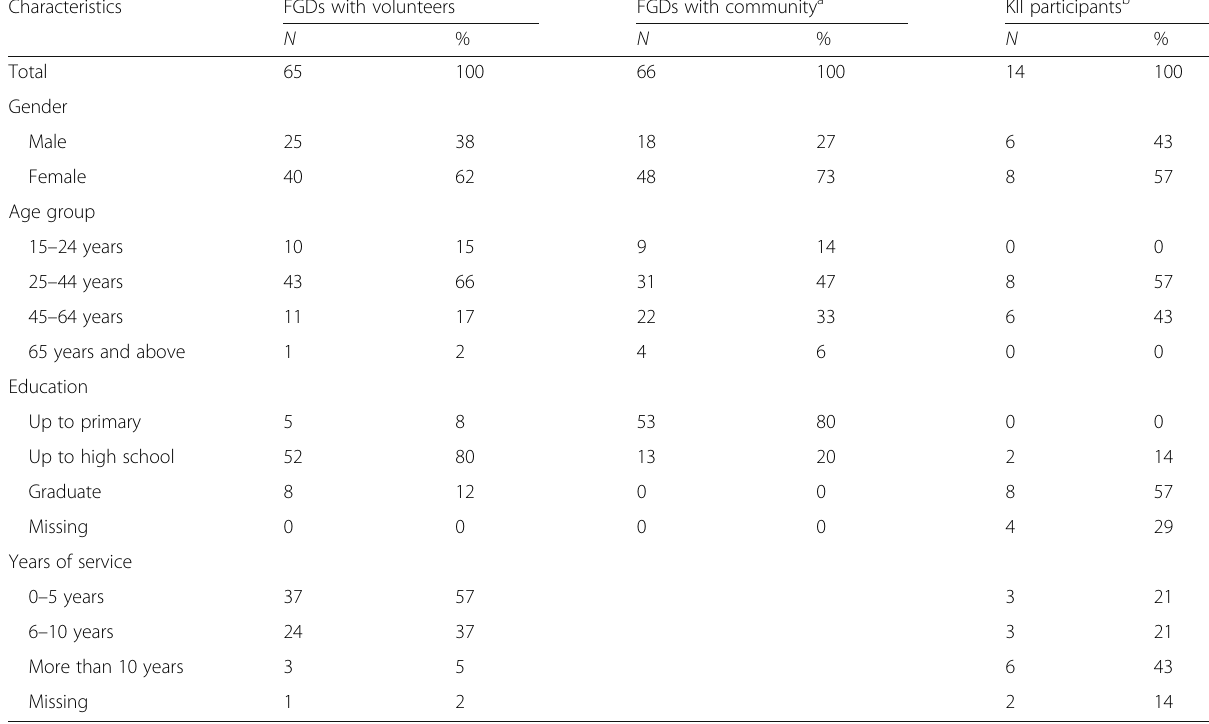
Table 3 Socio-demographic characteristics of the participants of the focus group discussions and key informant interviews conducted in four selected townships in Myanmar, 2017 Characteristics